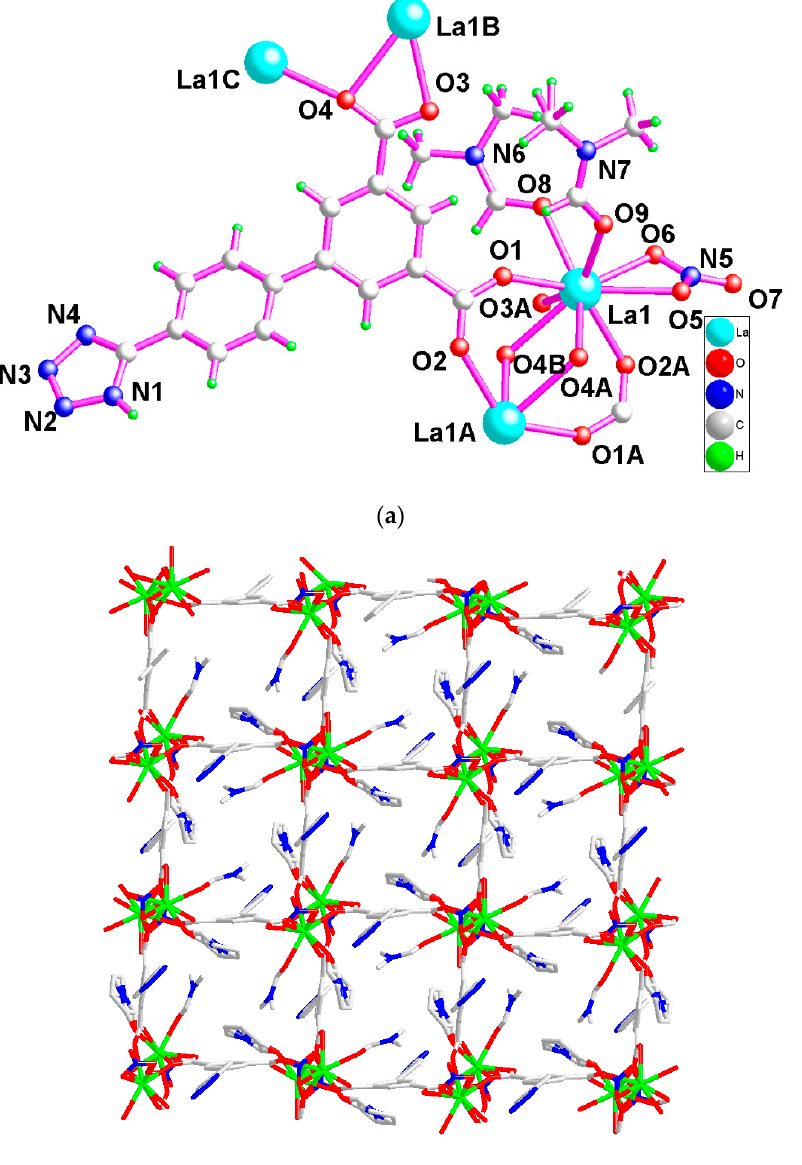
Figure 1. ( a ) The fundamental structure of 1 (symmetry codes: A 0.5 − x, 1.5 − y, 1 − z; B x,1 −